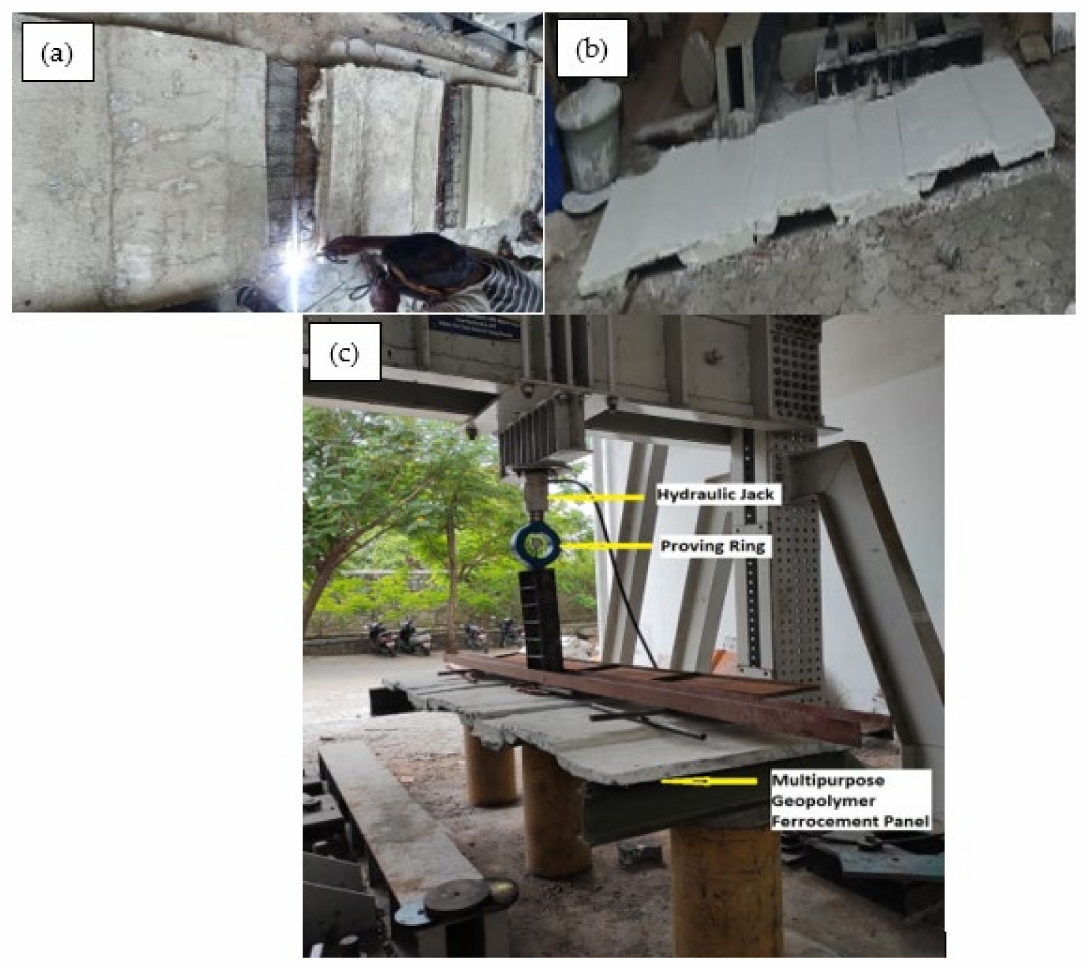
Figure 6. Preparation and testing of multipurpose geopolymer ferrocement panels ( a ) Welding of multipurpose panels, ( b ) Prepared multipurpose panels, and ( c ) Test setup for multipurpose